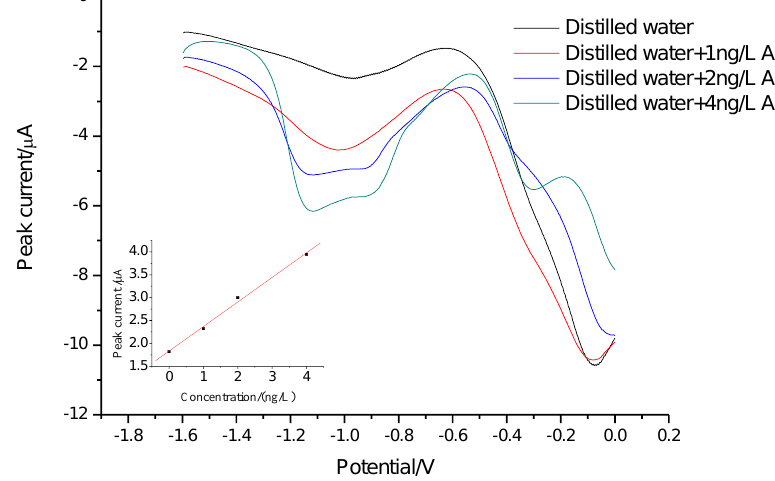
Figure 7. LPME – SW-ASV of Al(III) in commercial distilled water sample with standard addition method. The inset shows the corresponding standard plot. LPME conditions are same as Figure 3. The parameters of SW-ASV are same as Figure 4.